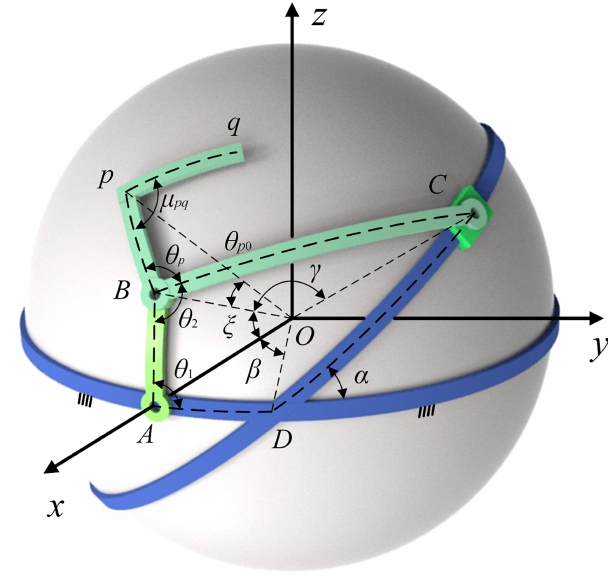
Figure 2. Model of spherical four-bar crank slider rigid-body guid- ance